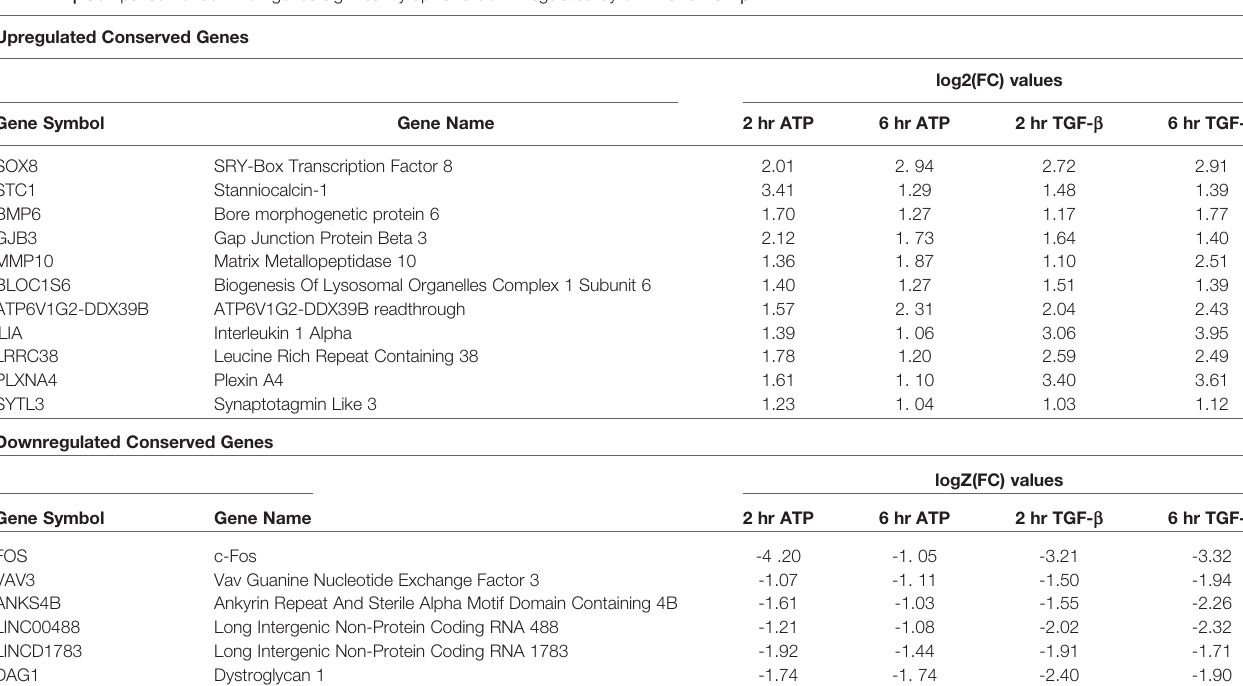
TABLE 1 | Comparison of common genes signi fi cantly up- and down-regulated by eATP and TGF- b . Upregulated Conserved